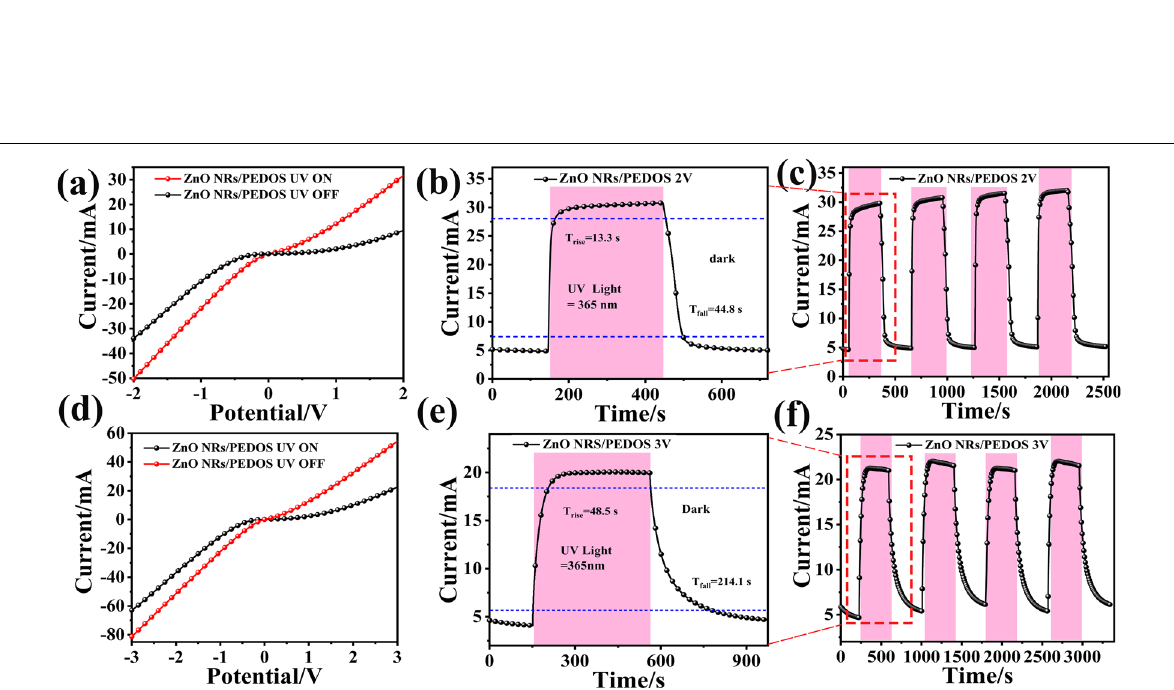
Fig. 6 I–V curves ( a ) current–time ( b ) and circulating current–time ( c ) diagram of ZnO-NRs/PEDOS UV PD under bias 2 V and I–V curves ( d ) current– time ( e ) and circulating current–time ( f ) diagram of ZnO-NRs/PEDOS UV PD under different bias 3